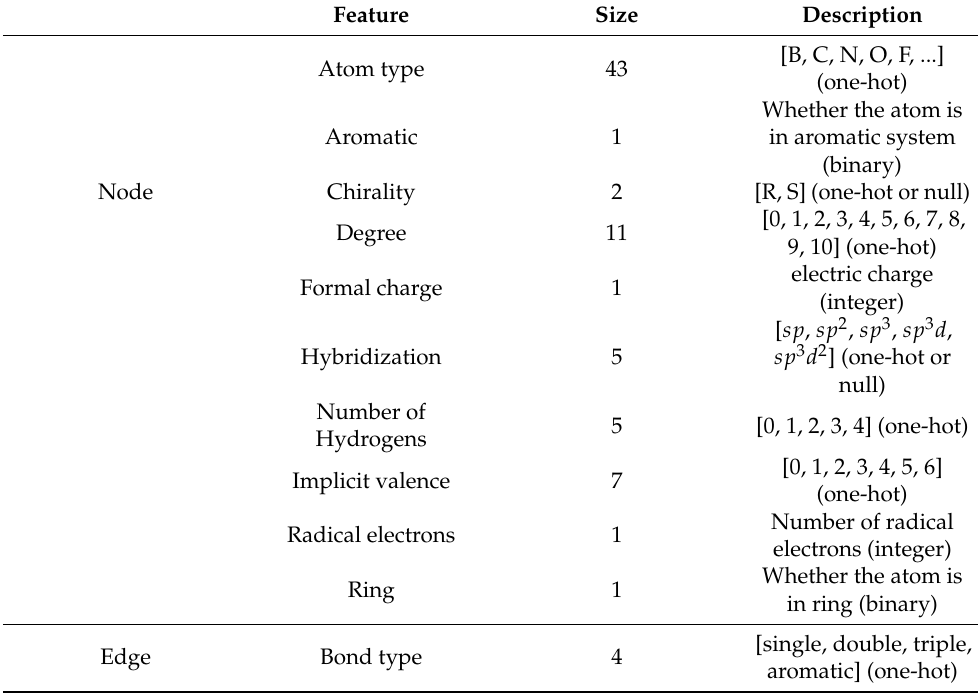
Table A2. Atomic and bond features of the drug